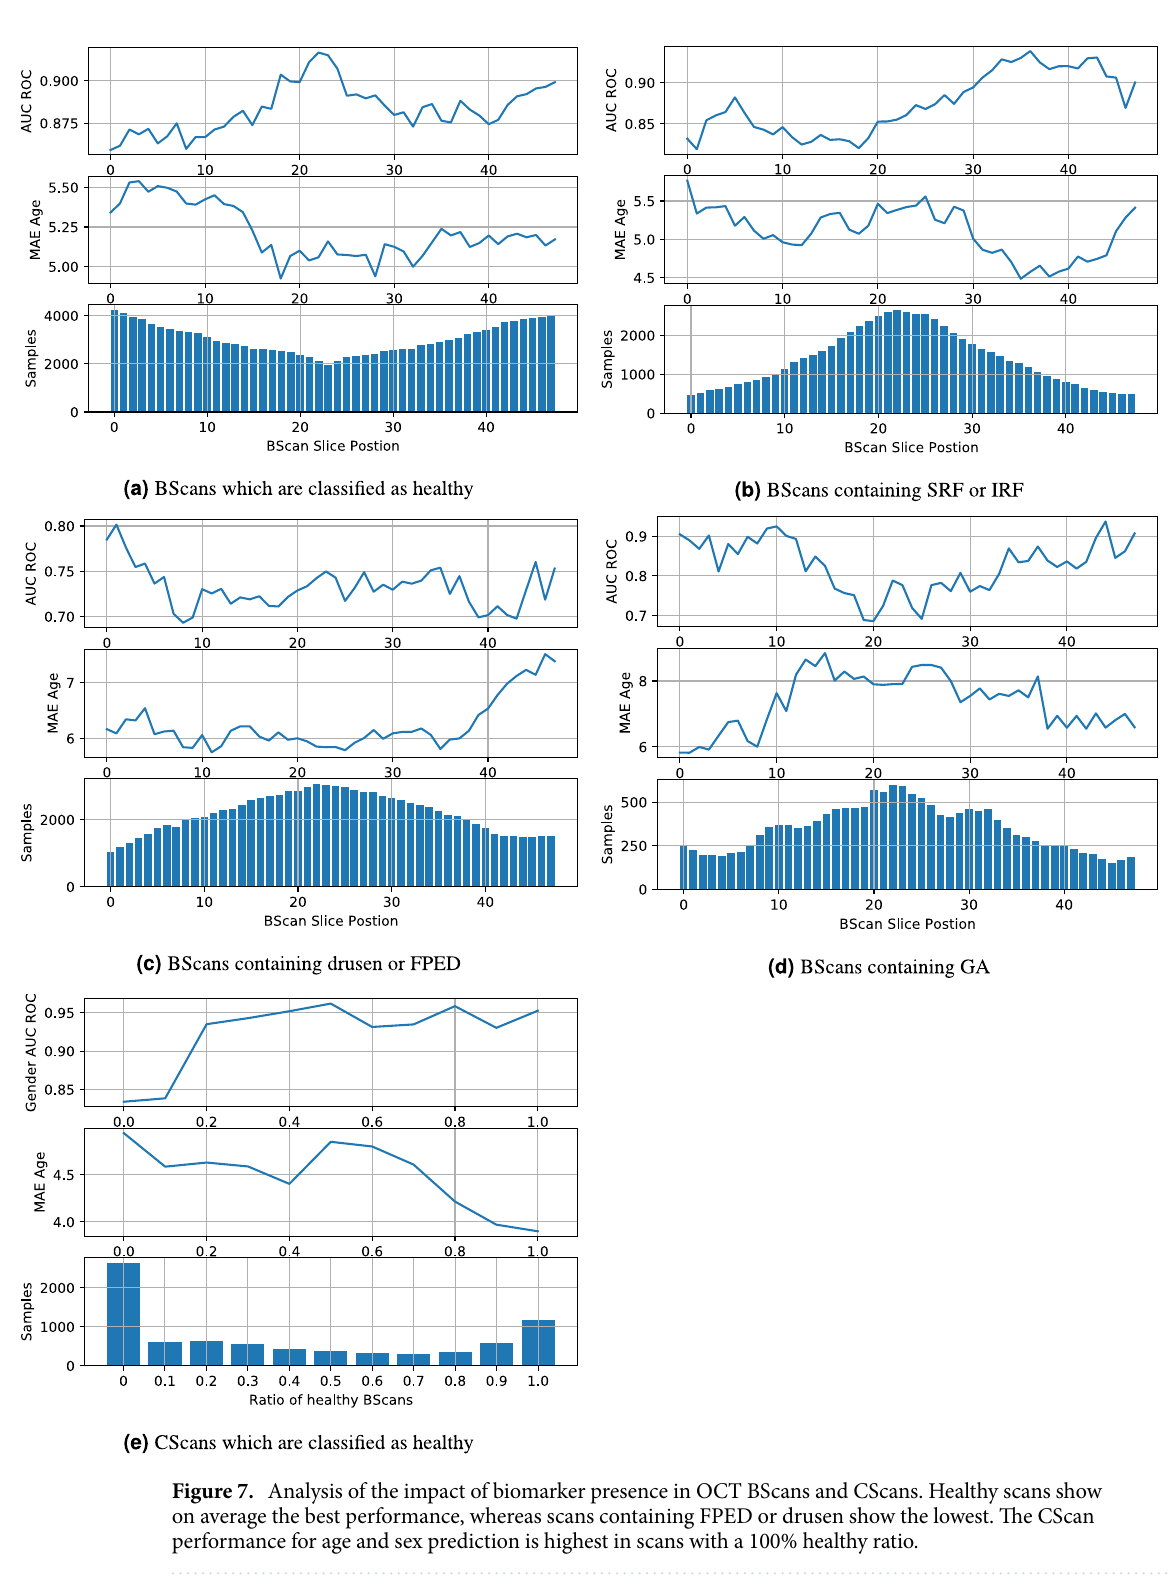
performance for age and sex prediction is highest in scans with a 100% healthy